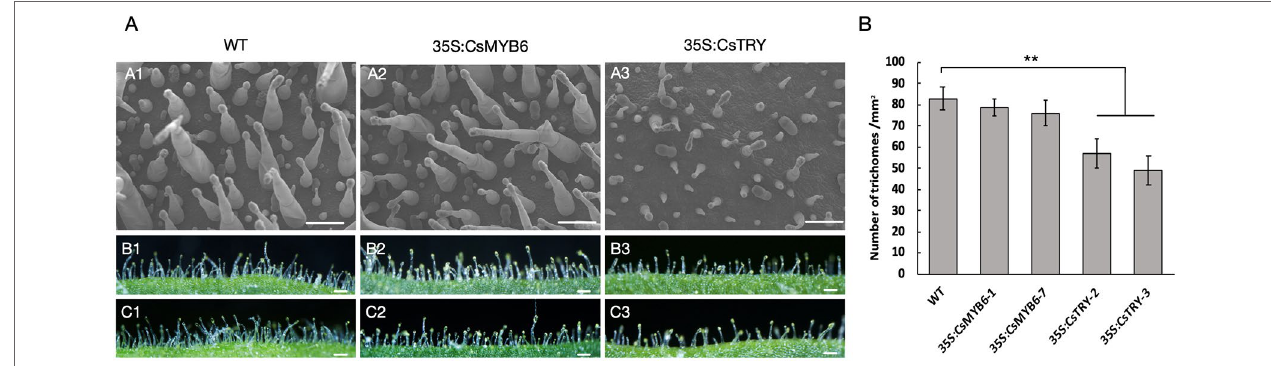
FIgURE 2 | The morphology and quantity of trichome in wild type and 35S:CsTRY, 35S:CsMYB6 tobacco lines (A) Patterns of trichome distribution on the leave surface of T1 generation plants of CsTRY and CsMYB6 overexpression transgenic tobacco. Bars = 100 µm. (B) Number of trichomes on 1 mm -2 adaxial surface of the leave of T1 generation plants of CsTRY and CsMYB6 overexpression transformed lines and the wild-type. Error bars represent +SE. Significant differences were determined according to Duncan’s multiple range test (P < 0.05) or Student’s t-test (**P < 0.01).